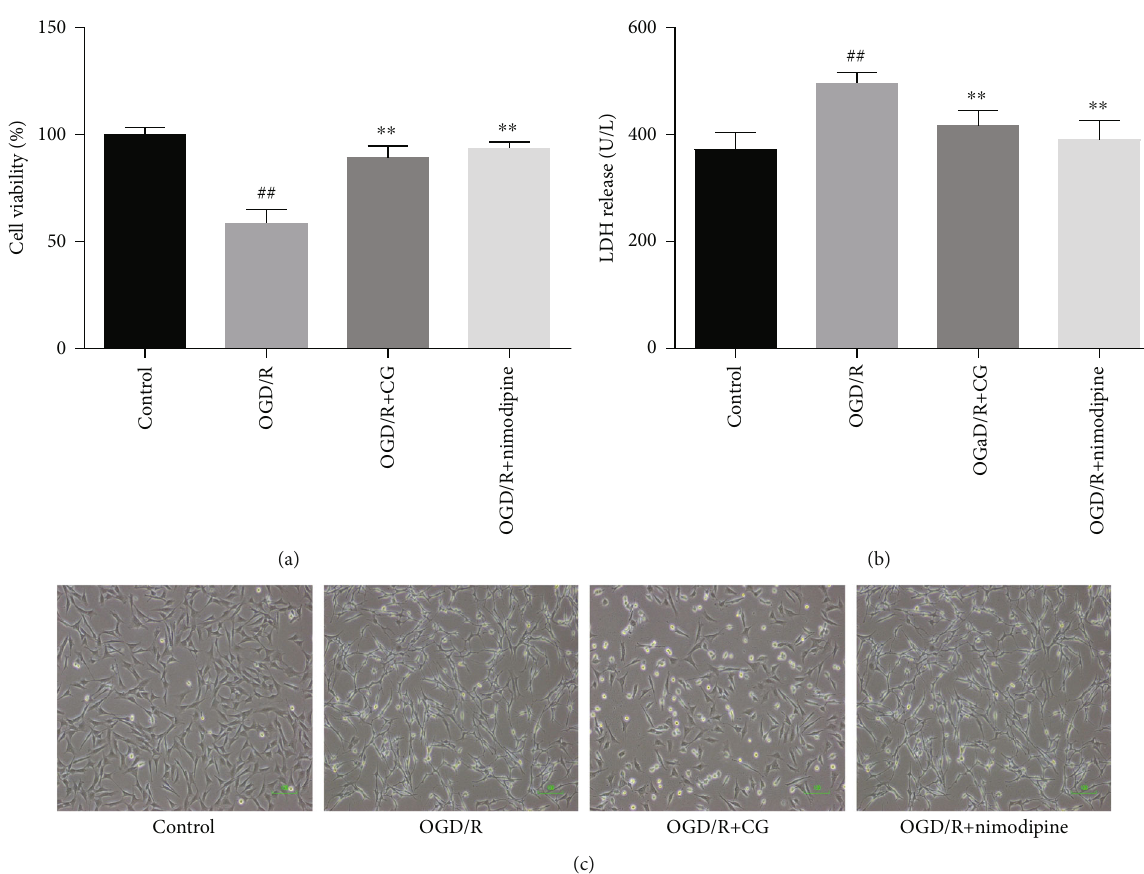
Figure 2: HT22 cells were treated with 8h of OGD and then reoxygenated in the presence of CG for 6 h. (a) Cell viability was detected by CCK-8 assay. (b) Cytotoxicity was determined with LDH assays. (c) Cell morphology was evaluated by a biological microscope. Three independent experiments were performed, and data were expressed as the mean ± SD . ## P < 0 : 01 vs. control group, ∗∗ P < 0 : 01 vs. OGD/R